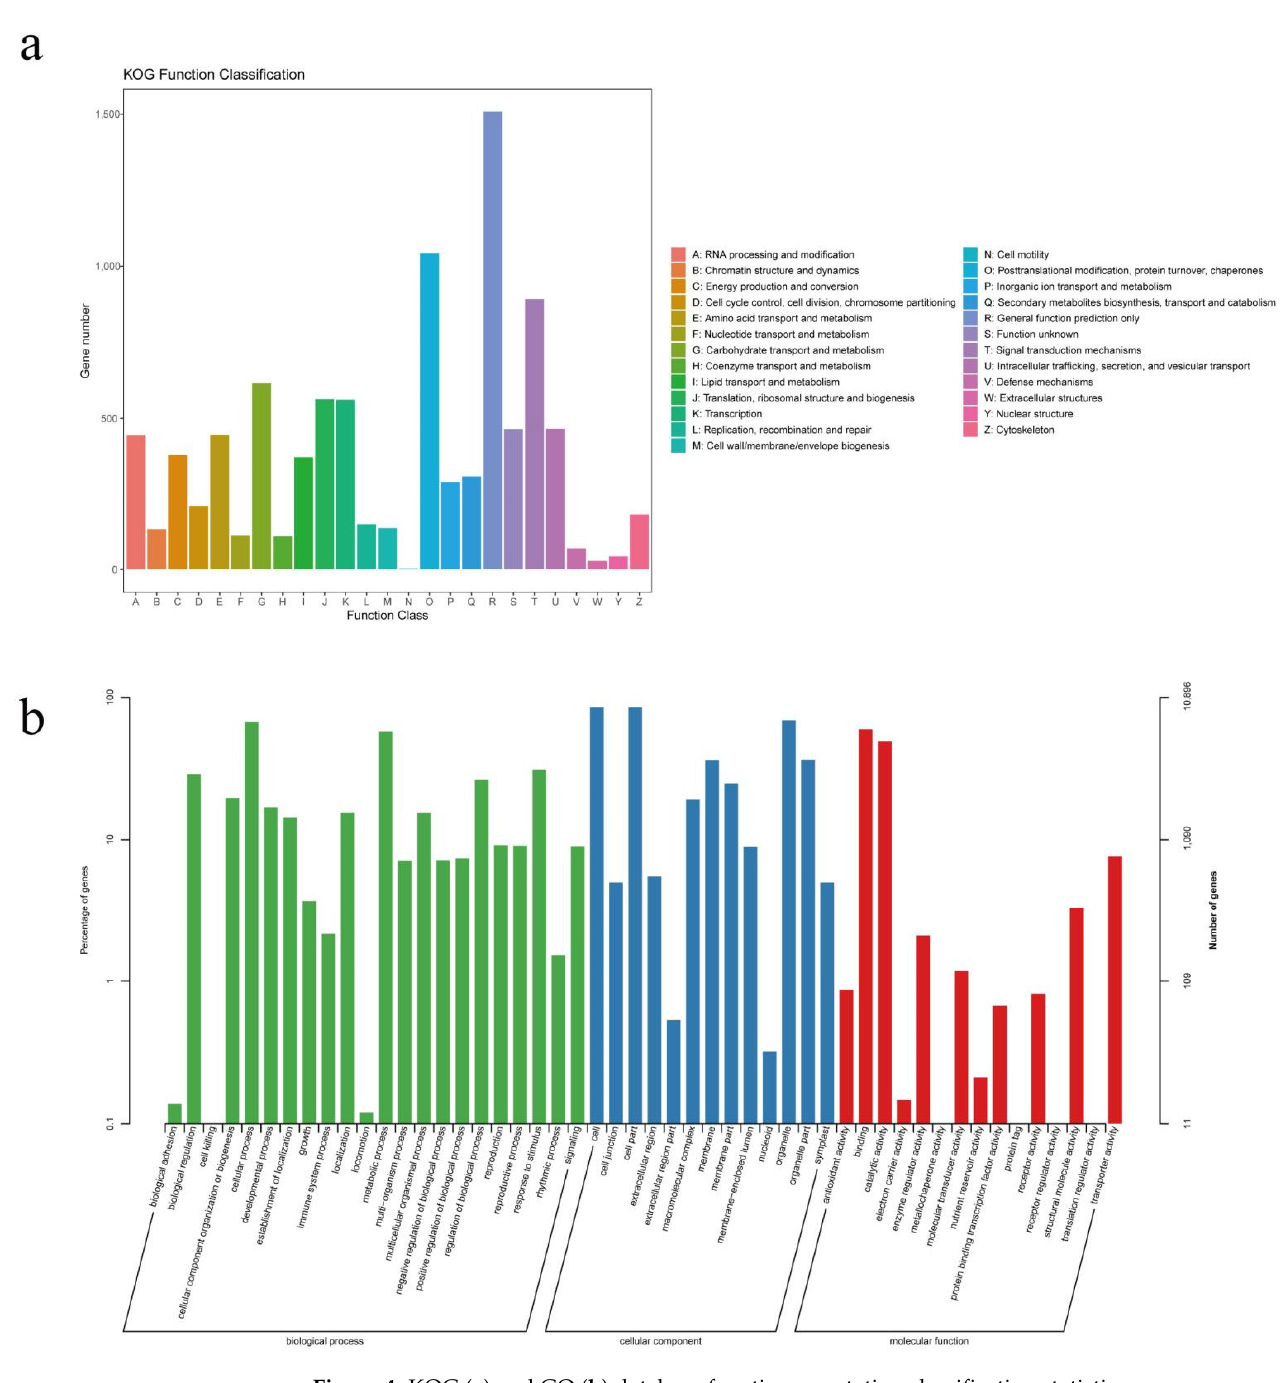
Figure 4. KOG ( a ) and GO ( b ) database function annotation classification statistics.